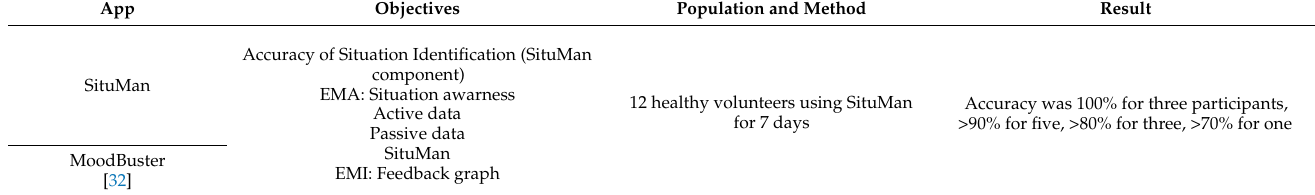
Table 2. Summary of applications and main results of